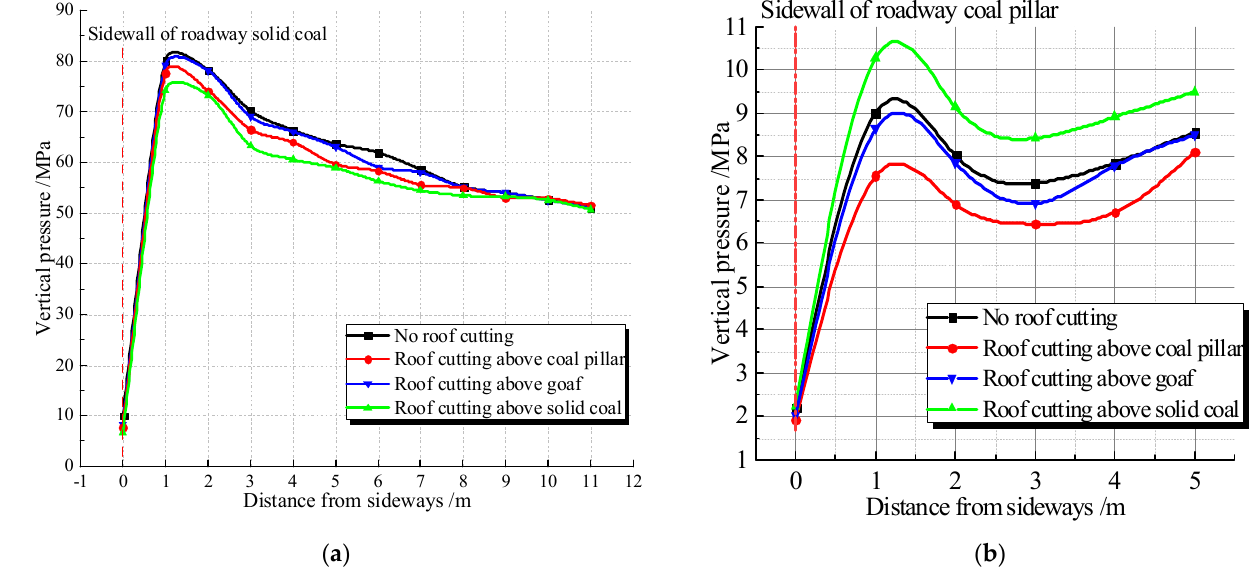
Figure 7. The effect of different roof cutting angles on the surrounding rock stresses of the gob—side entry; ( a ) Vertical stress at solid coal side of roadway; ( b ) Vertical stress at coal pillar side of roadway.